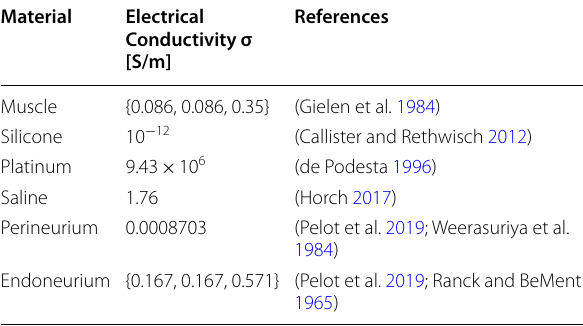
Table 3 Material conductivities used in the finite element model of mouse VNS